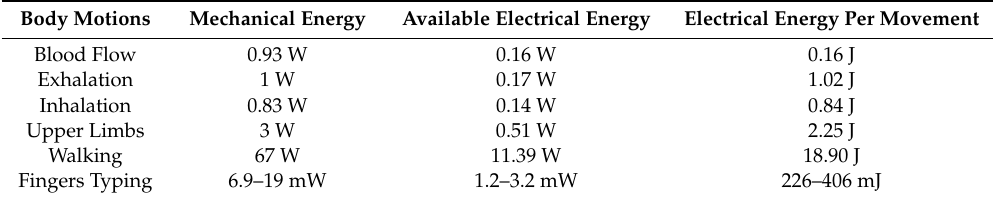
Table 1. Energy potential in human body motions